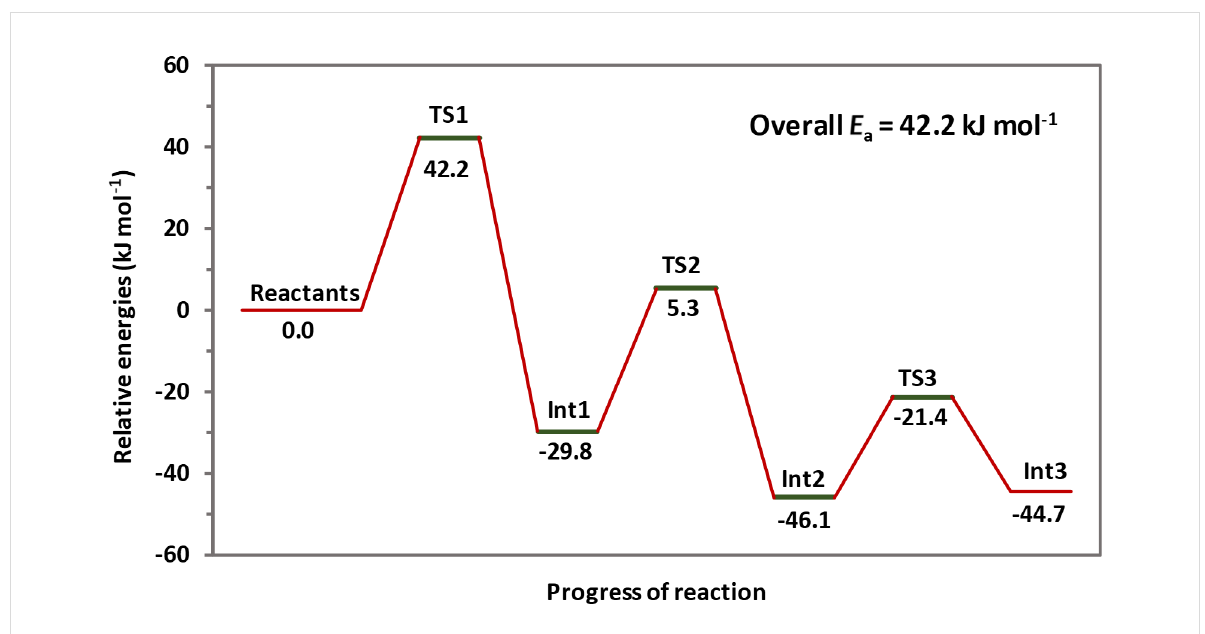
Figure 5: Relative energies of the reactants, transition states ( TS1 – TS3 ), and intermediates ( Int1 – Int3 ) of the proposed reaction mechanism, com- puted at the B3LYP/6-311++G(d,p) level of theory in DMF as the solvent.